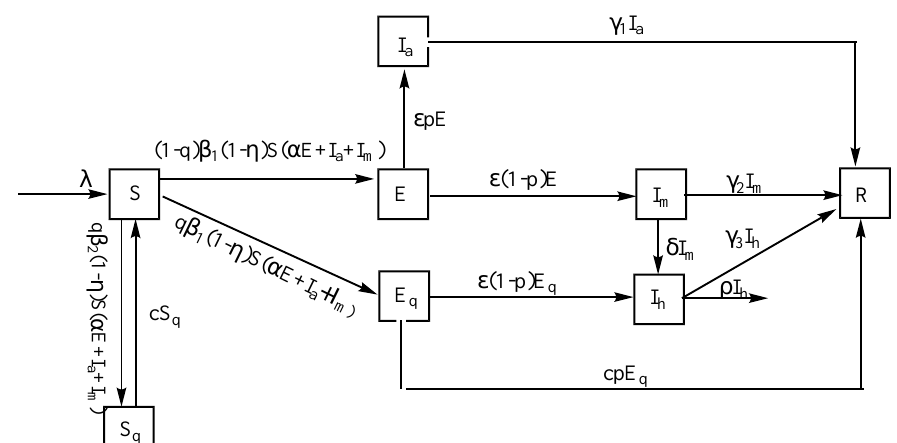
Fig. 3: Transmission mechanism Figure 3. Transmission